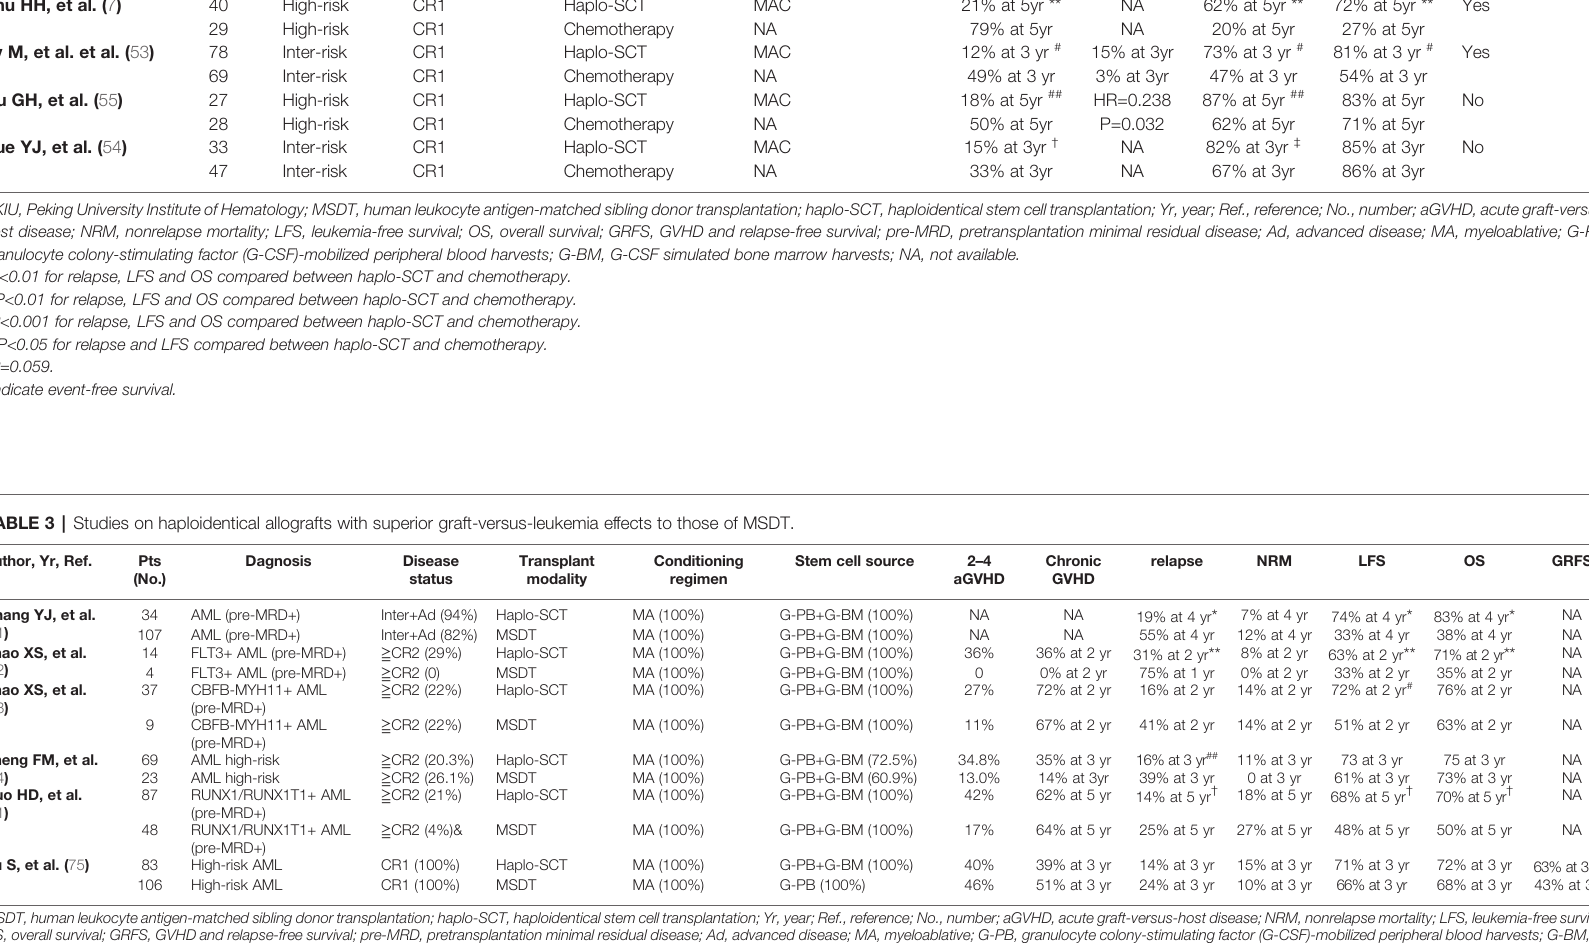
TABLE 2 | Published PKIU studies comparing haplo-SCT with chemotherapy alone in adult and pediatric AML cases. Author, Yr, Ref. Huang XJ, et al. ( 5 )